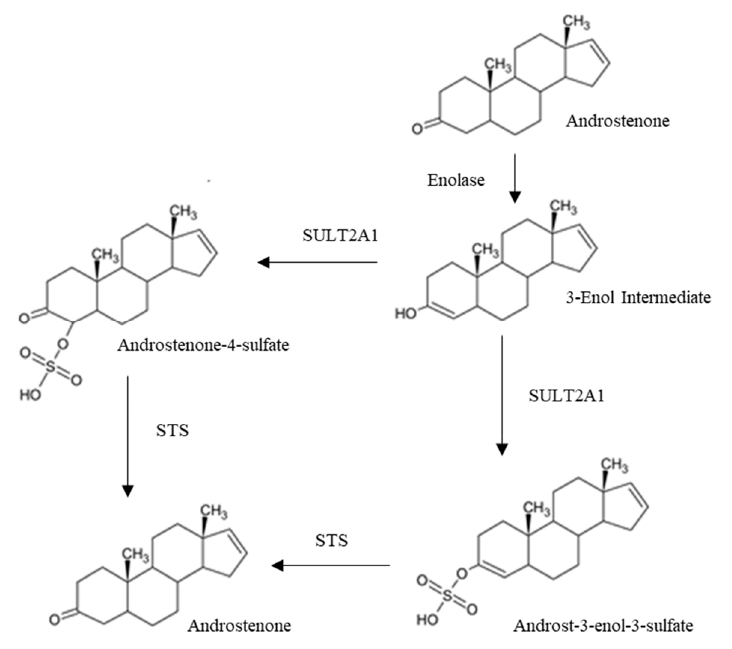
Figure 3. Propose mechanism for the reversible sulfation of androstenone.